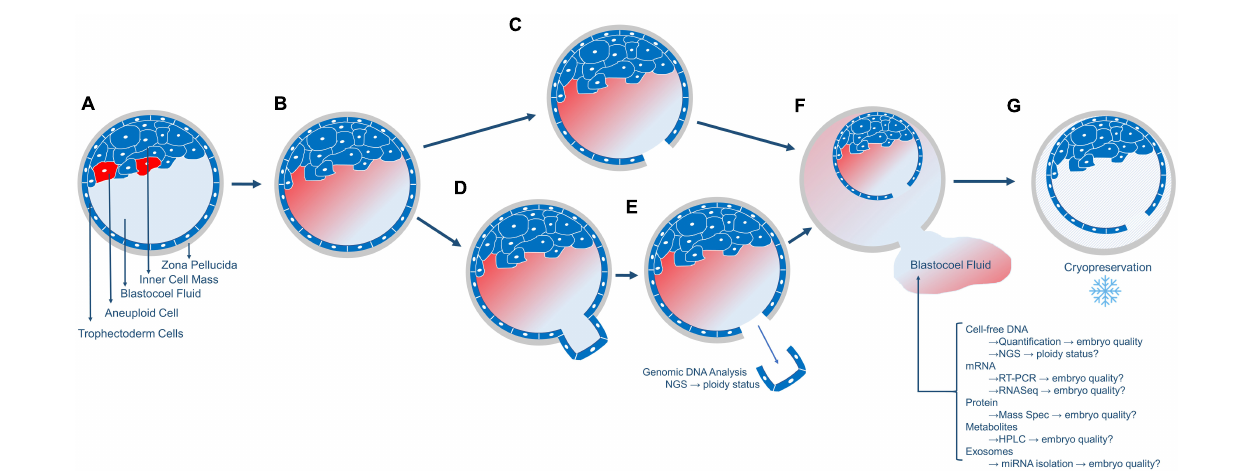
FIGURE 1 | Overview of the collection of blastocoel fluid. (A) The day5/6 blastocyst includes the fluid-filled blastocoel cavity in contact with the inner cell mass. Red cells in the inner cell mass represent aneuploid cells that will or has undergo apoptosis. (B) The cells that underwent apoptosis released their contents (cell-free DNA, mRNA, proteins, metabolites, and exosomes) into the blastocoel fluid. (C) Blastocysts that will not undergo biopsy or embryo transfer are prepared for cryopreservation by using a laser to release the blastocoel fluid into the surrounding media drop. (D,E) Blastocysts that will undergo embryo biopsy for PGT-A will typically have 3–10 trophectoderm (TE) cells removed via laser-assisted cell lysis and pipette suction, with the biopsied cells sent off-site for genetic analysis. (F) Following either micromanipulation process, the blastocoel fluid is expelled from the blastocyst into the surrounding media and this blastocoel conditioned media can be collected and stored for subsequent analyses of the molecules as listed. (G) The blastocyst is cryopreserved and stored. Blastocysts are thawed once PGT-A results are known for embryo transfer.